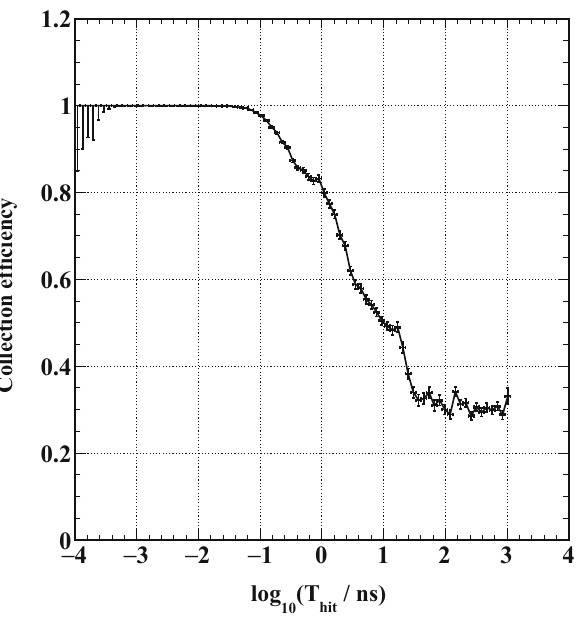
Fig. 14 The hit collection efficiency of Arbor versus the true time of ECAL hits, calculated in the 10 GeV π +